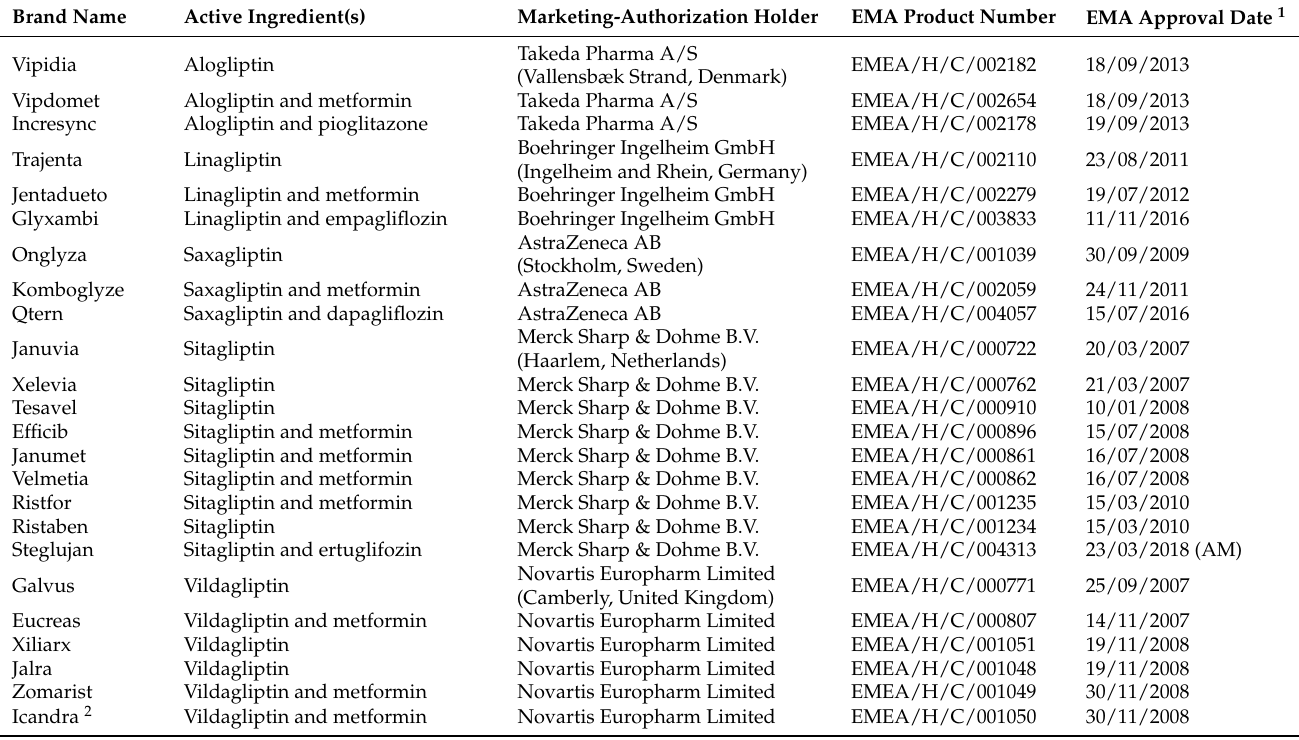
Table 1. List of European Medicines Agency (EMA)-approved DPP4 inhibitors.